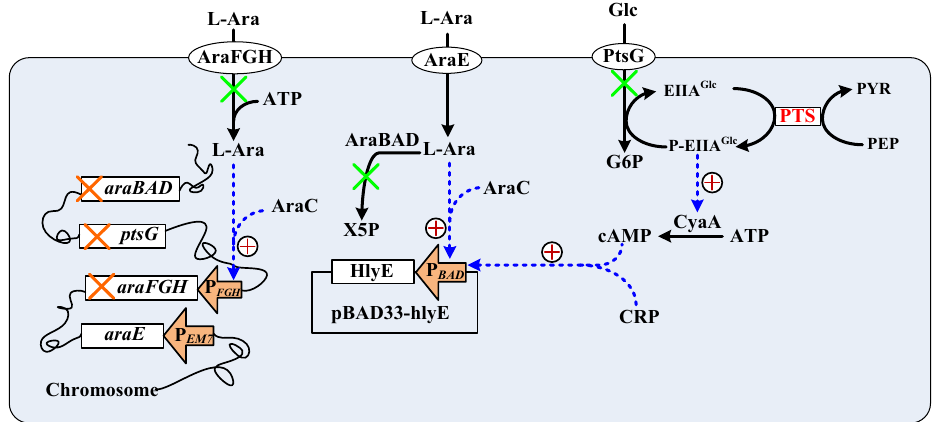
Figure 1. Schematic illustration of the strategy applied to rewire EcN metabolism. Shown were metabolic pathways involved in this study. Pathways of blockage and genes of deletion were marked with “X”. Through the PEP:carbohydrate phosphotransferase system (PTS), EIIA Glc receives the phosphoryl group from phosphoenolpyruvate (PEP) and becomes phosphorylated (P-EIIA Glc ) associated with the production of pyruvate (PYR). During translocation via PTS, glucose (Glc) is phosphorylated to glucose 6-phosphate (G6P) by P-EIIA Glc . The araBAD operon which consists of araB (encoding L-ribulokinase), araA (encoding L-arabinose isomerase), and araD (encoding L-ribulose-5-phosphate 4-epimerase) mediates conversion of L-arabinose (L-Ara) to D-xylulose 5-phosphate (X5P). P BAD is activated (“ + ”) by regulator proteins involving AraC and CRP which complex with L-Ara and cAMP, respectively. Refer to text for more details. Notes: AraC, arabinose regulator; AraE, arabinose-proton symporter (encoded by araE ); AraFGH, arabinose ABC transporter (encoded by araFGH operon); CRP, cAMP receptor protein; CyaA, adenylate cyclase; PtsG, glucose transporter (encoded by ptsG ), P FGH , endogenous promoter of araFGH